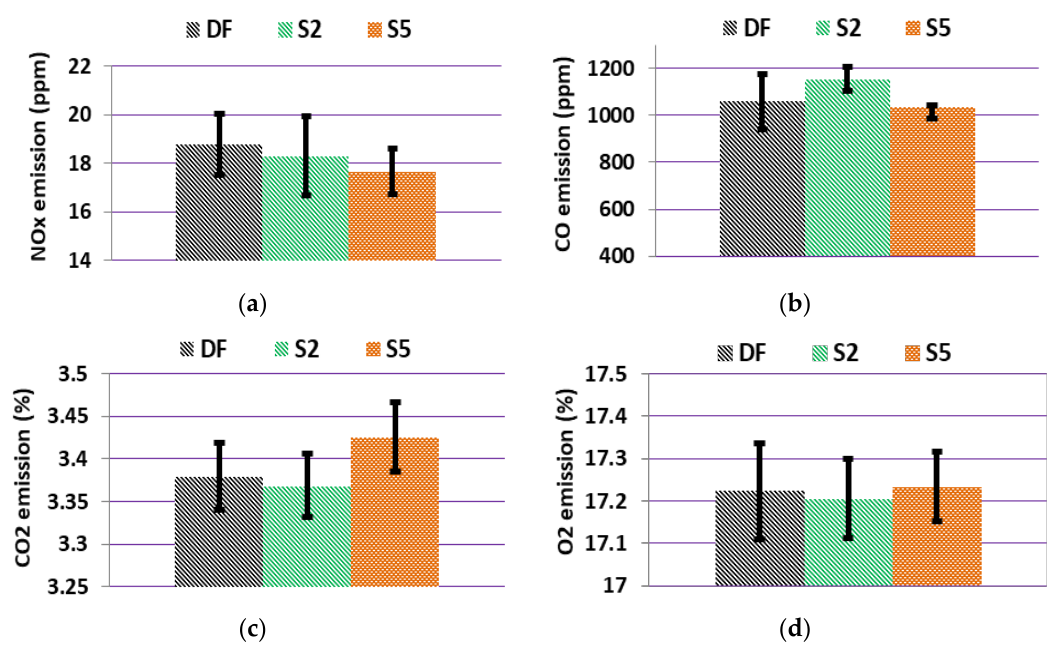
Figure 11. Gas turbine emission at 80k rpm; ( a ) NOx, ( b ) CO, ( c ) CO2, ( d ) O2.